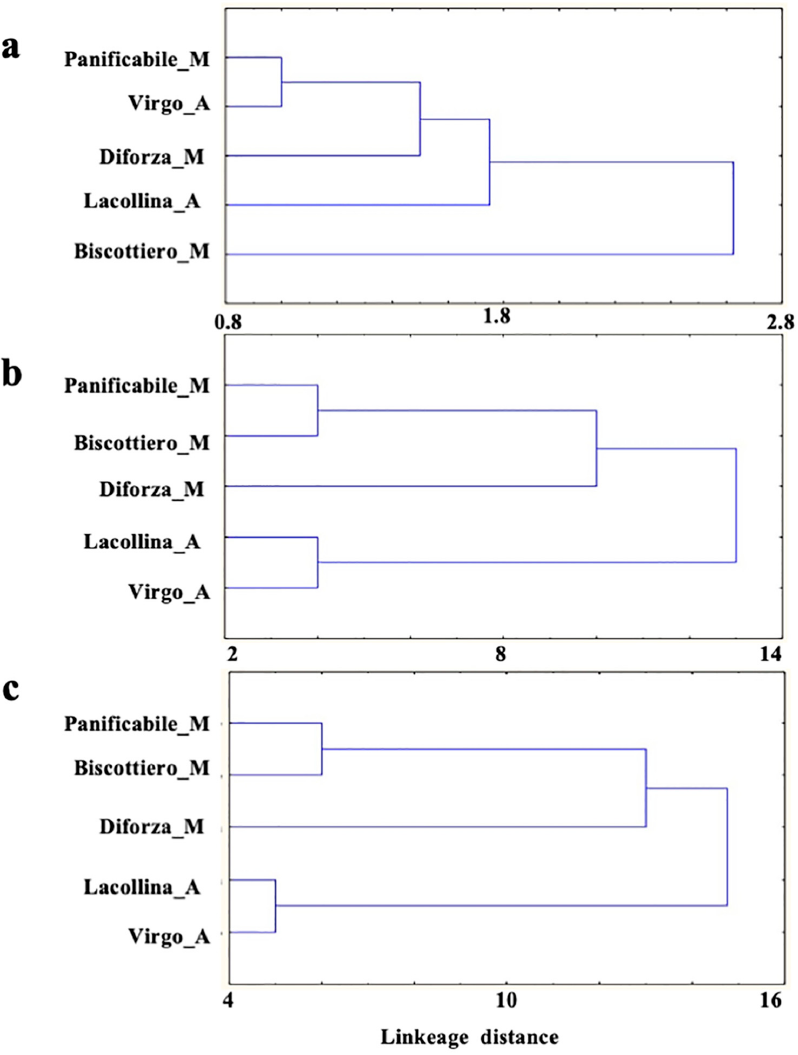
Figure 1. Dendrogram of hierarchical relatedness based on ( a ) albumins and globulins, ( b ) gliadins and glutenins, and ( c ) total protein polymorphisms between in three commercially available modern wheat mixes (denoted by M) and two old wheat mixes (denoted by A).